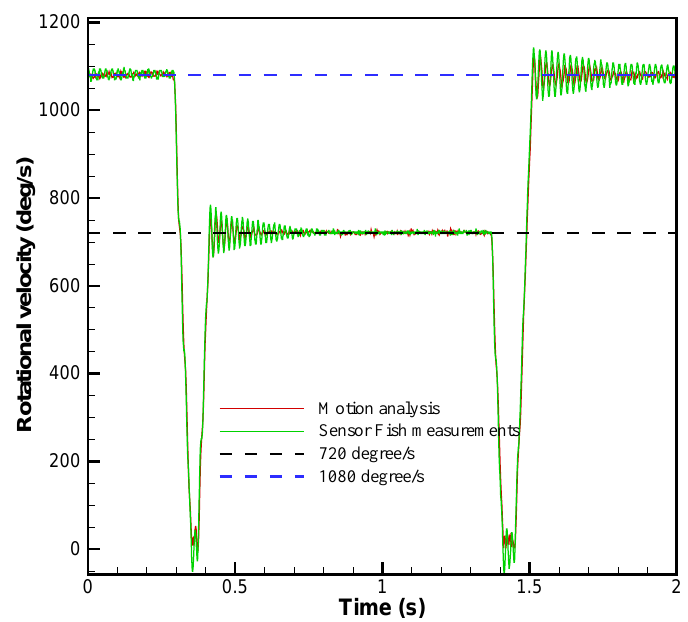
Figure 7 . A Sensor Fish is mounted in a rotation test fixture with its x-axis parallel to the rotational axis of the fixture. The rotational velocity of the fixture alternates between 1,080 and 720